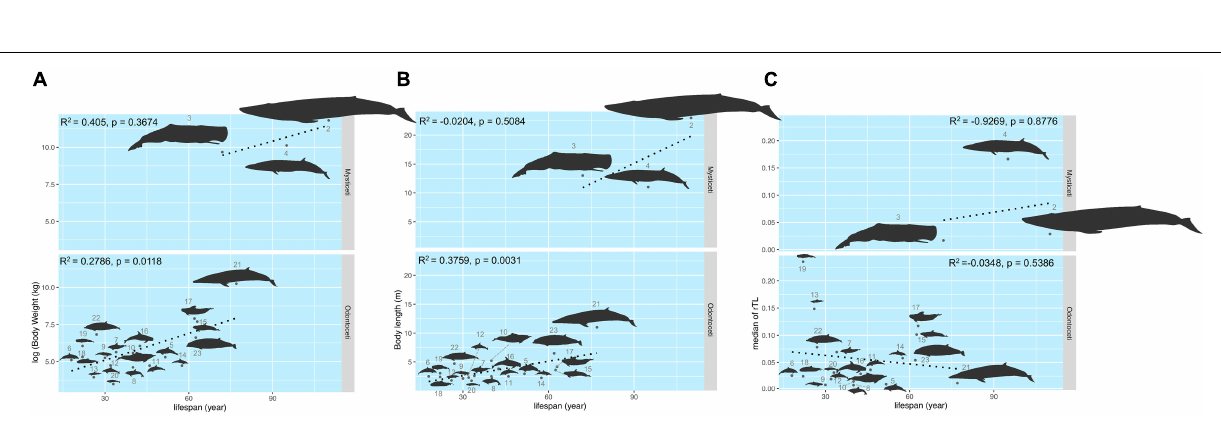
FIGURE 3 | The relationship of the maximum lifespan with log (body weight) (A) , body length (B) , and median rTL (C) across Mysticeti and Odonotoceti. The size of the figures illustrates in accordance to the real ratio. The numbers represent species of marine mammals as depicted in Table 1 .